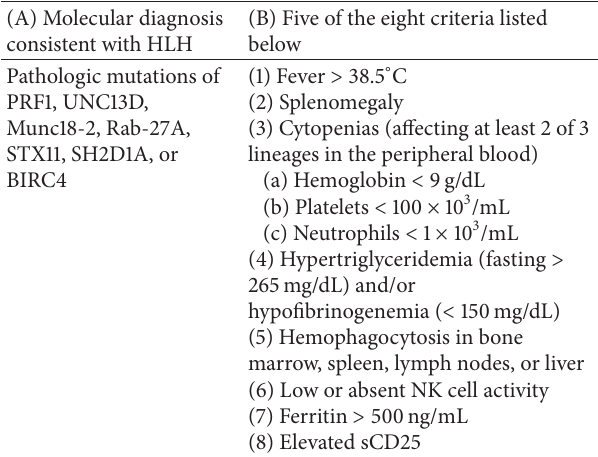
Table 1: Diagnostic criteria for hemophagocytic lymphohistiocyto-